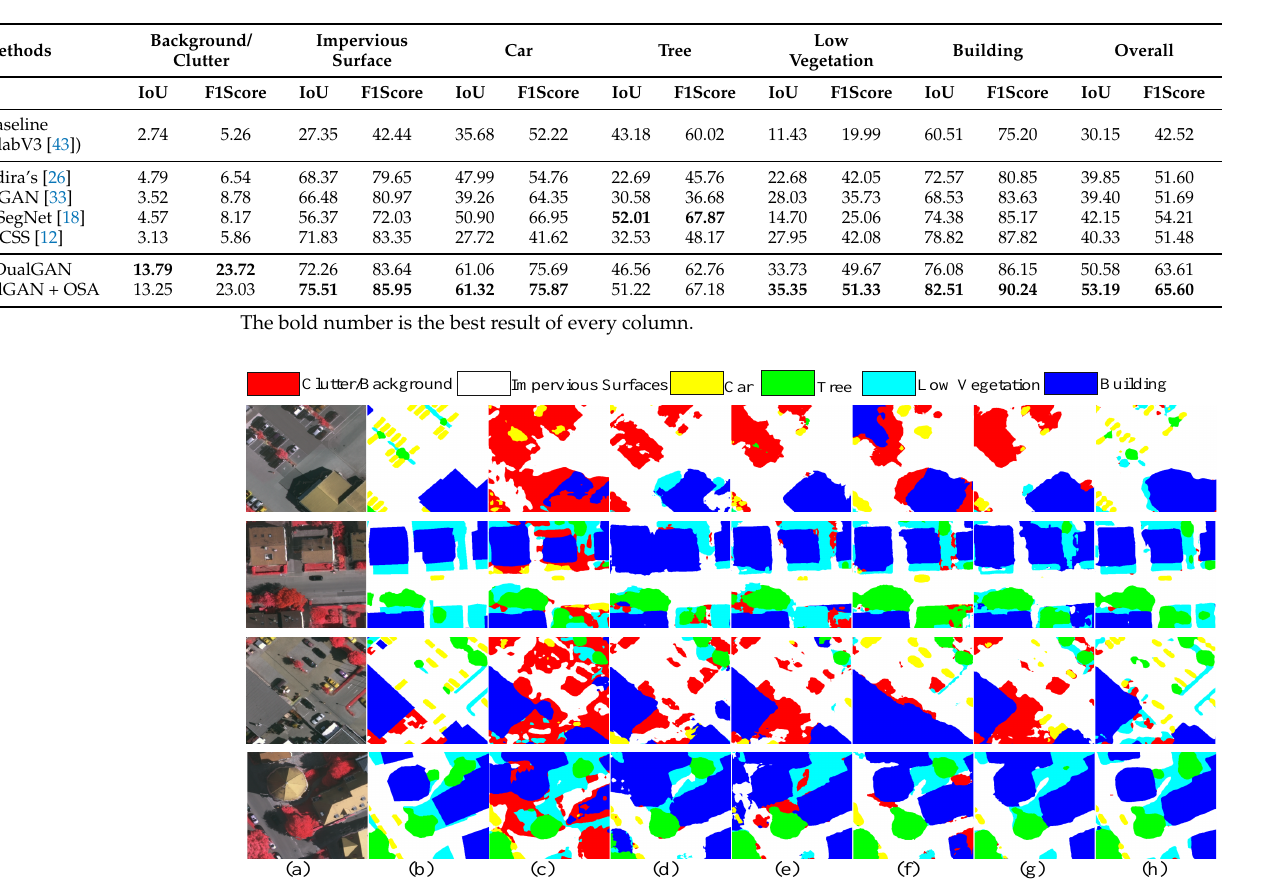
Table 3. The quantitative results of the cross-domain semantic segmentation from PotsdamIRRG to BC403.